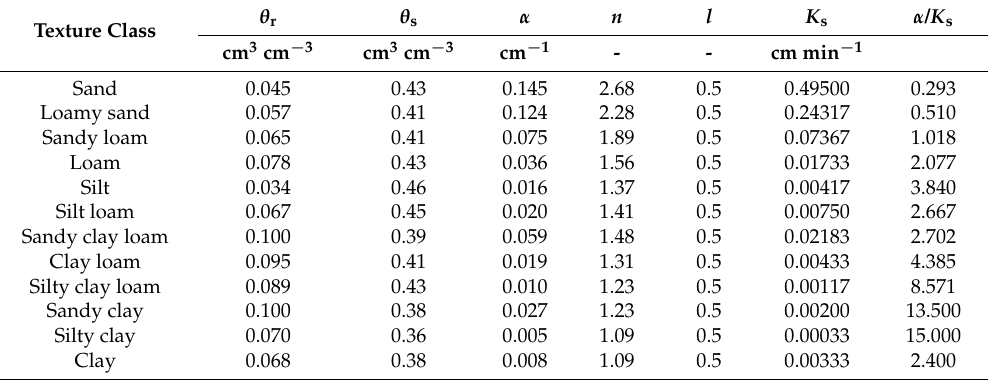
Table 1. Soil hydraulic parameters of the van Genuchten–Mualem model for 12 soils.